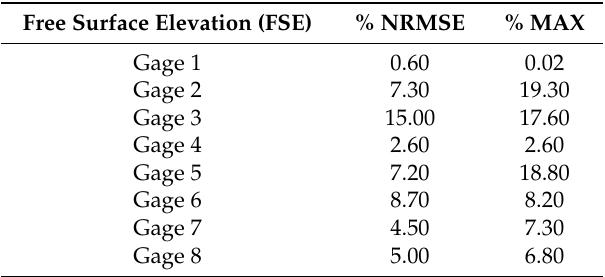
Table 1. Error statistics of numerical results for free surface elevation time series recorded at each gage.